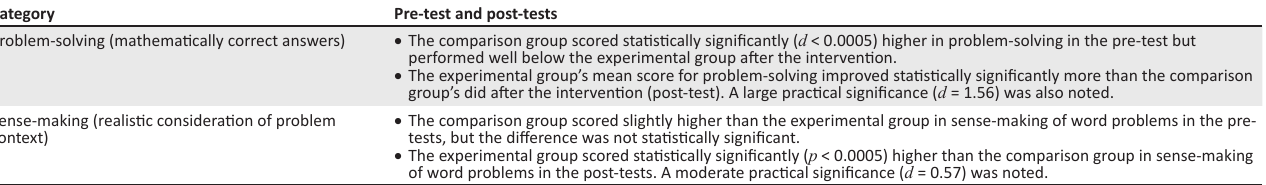
TABLE 5 : Results summary. Category Pre-test and post-tests Problem-solving (mathematically correct answers)